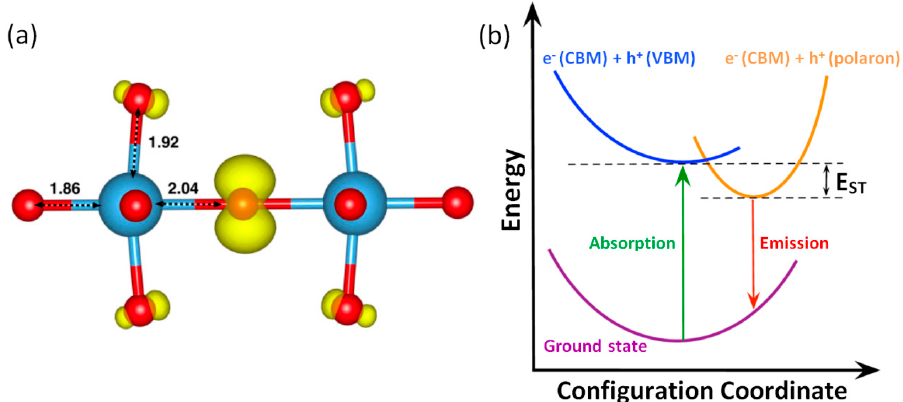
Figure 3. ( a ) Charge densities for the localized in-gap hole state. (Ti–O bond lengths are shown in Å).